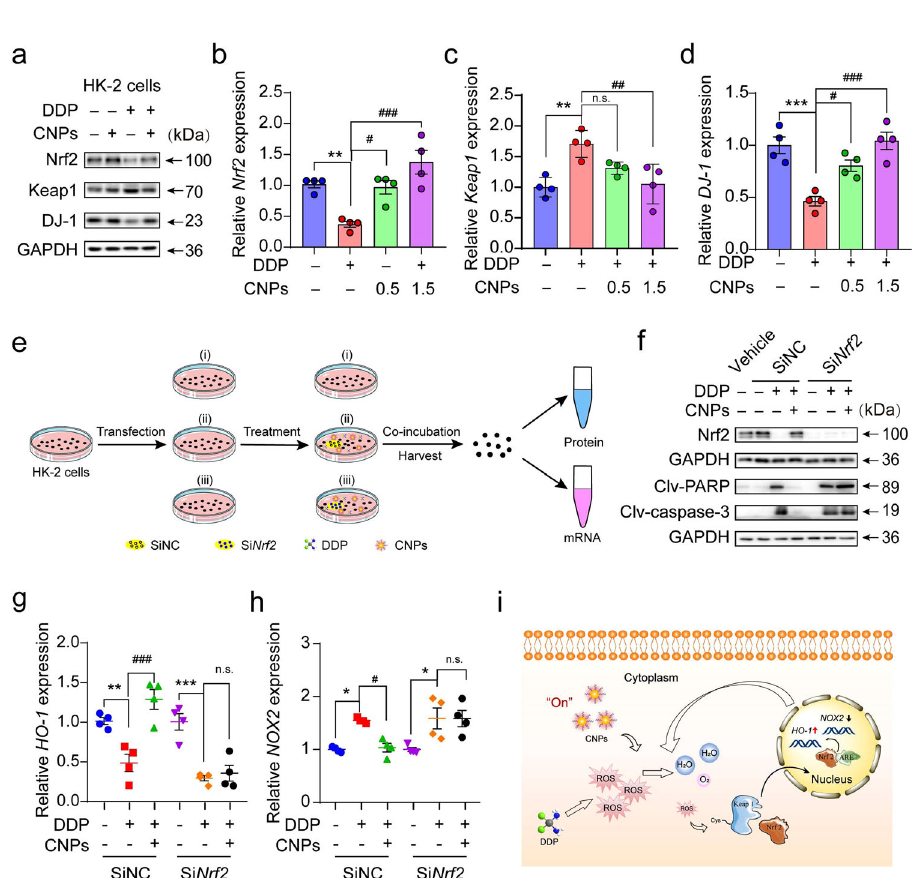
Fig. 5 CNPs counteract DDP-induced oxidative stress via activating Nrf2/Keap1 signaling pathway. a Western blot analysis of the Nrf2, Keap1, and DJ-1 levels in HK-2 cells after respective treatments with the vehicle, CNPs, DDP, and CNPs plus DDP. GAPDH served as a loading control. n = 2 independent experiments. b , c , d Relative mRNA expressions of Nrf2 ( b ), Keap1 ( c ), and DJ-1 ( d ) in the renal cortex from each group. n = 4 independent experiments. In b , P (DDP) = 0.0091, P (0.5 CNPs) = 0.015, P (1.5 CNPs) = 0.00026; in c , P (DDP) = 0.003, P (0.5 CNPs) = 0.0977, P (1.5 CNPs) = 0.0054; in d , P (DDP) = 0.0006, P = 0.0185, P = 0.00031. e Schematic diagram of the experimental setup to evaluate the role of Nrf2 by small interfering RNA (SiRNA) in vitro (0.5 CNPs) (1.5 CNPs) using western blot and qRT-PCR analysis. f Western blot analysis of Nrf2, clv-PARP and clv-caspase-3 levels in Si Nrf2 -transfected HK-2 cells. GAPDH served as a loading control. n = 2 independent experiments. g , h Relative mRNA expressions of HO-1 ( g ) and NOX2 ( h ) in the respective groups. n = 4 independent experiments. In g , P (siNC, DDP) = 0.0092, P (siNC, DDP + CNPs) = 0.0001, P (si Nrf2 , DDP) = 0.00046, P (si Nrf2 , DDP + CNPs) = 0.9958; in h , P (siNC, DDP) = 0.0241, P (siNC, = 0.0382, P = 0.0139, P = 1.000. i Schematic representation of the mechanism of CNPs in reducing ROS level. CNPs DDP + CNPs) (si Nrf2 , DDP) (si Nrf2 , DDP + CNPs) decompose DDP-induced H 2 O 2 , a predominant cellular ROS, into H 2 O and O 2 . Meanwhile, the minimally residual amounts of ROS activate the Nrf2/Keap1 signaling pathway. Speci fi cally, Nrf2 moves into the nucleus and subsequently binds to the antioxidant response elements (ARE), leading to the upregulation of the antioxidant gene ( HO-1 ) and downregulation of the pro-oxidant gene ( NOX2 ). These gene regulations can further detoxify ROS. Each experiment was repeated three times independently. Data are presented as means±SEM., * P <0.05, ** P <0.01, *** P <0.001, # P <0.05, ## P <0.01, ### P <0.001, n.s., no signi fi cance; one-way ANOVA with multiple comparisons test. Source data are provided as a Source Data fi